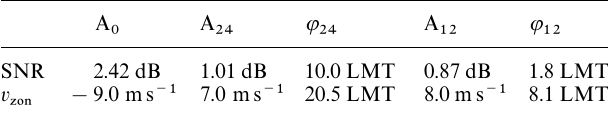
Table 2. Diurnal and semidiurnal tidal components of the mean SNR after ALOMAR SOUSY and zonal-wind data from MF-radar observations at an altitude of 85 km shown in Fig. 11